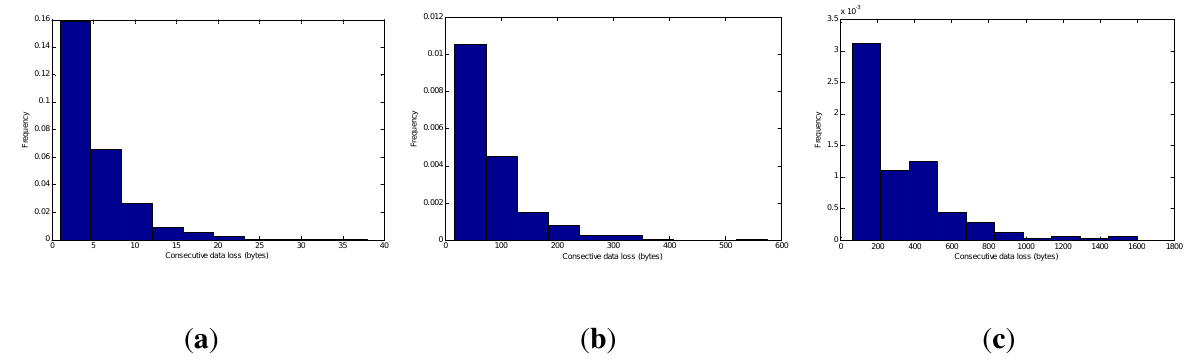
Figure 5. Frequency histogram of consecutive data loss. ( a ) Consecutive loss with the payload length being one byte; ( b ) consecutive loss with the payload length being 16 bytes; ( c ) consecutive loss with payload length being 64 bytes.